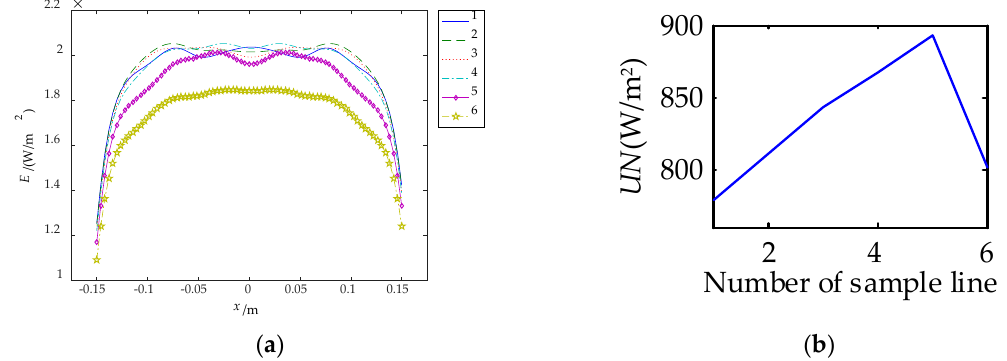
Figure 10. Irradiance distribution and uniformity of sample line. ( a ) Irradiance distribution; ( b ) uniformity.